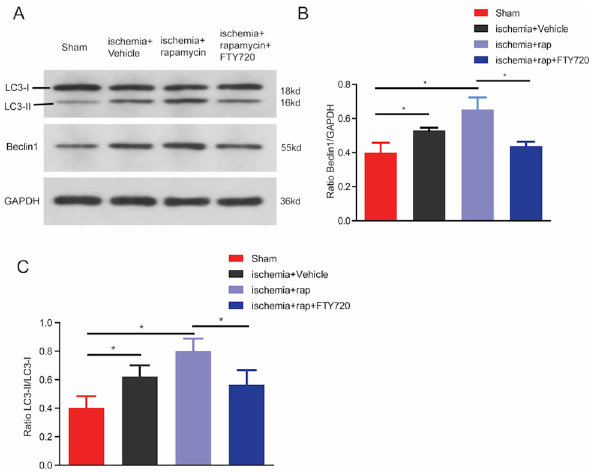
Fig 5. FTY720 reversesactivation of autophagy induced by mTOR inhibitor, rapamycin. A, The impact of FTY720 and rapamycinon the expressionof Beclin1 and LC3 was evaluatedby western blotting. Results are representative of 4 independentexperiments. B, Quantificationof the results in panel A. (n = 4 for each group, * p < 0.05 vs. sham group, * p < 0.01 vs. ischemia+rapamycingroup, one-wayANOVA with Tukey post hoc test).